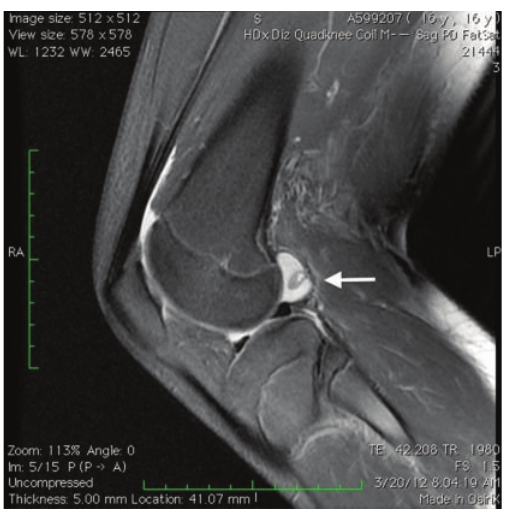
Figure 1: Sagittal MRI view of knee, demonstrating edema around the popliteus tendon.